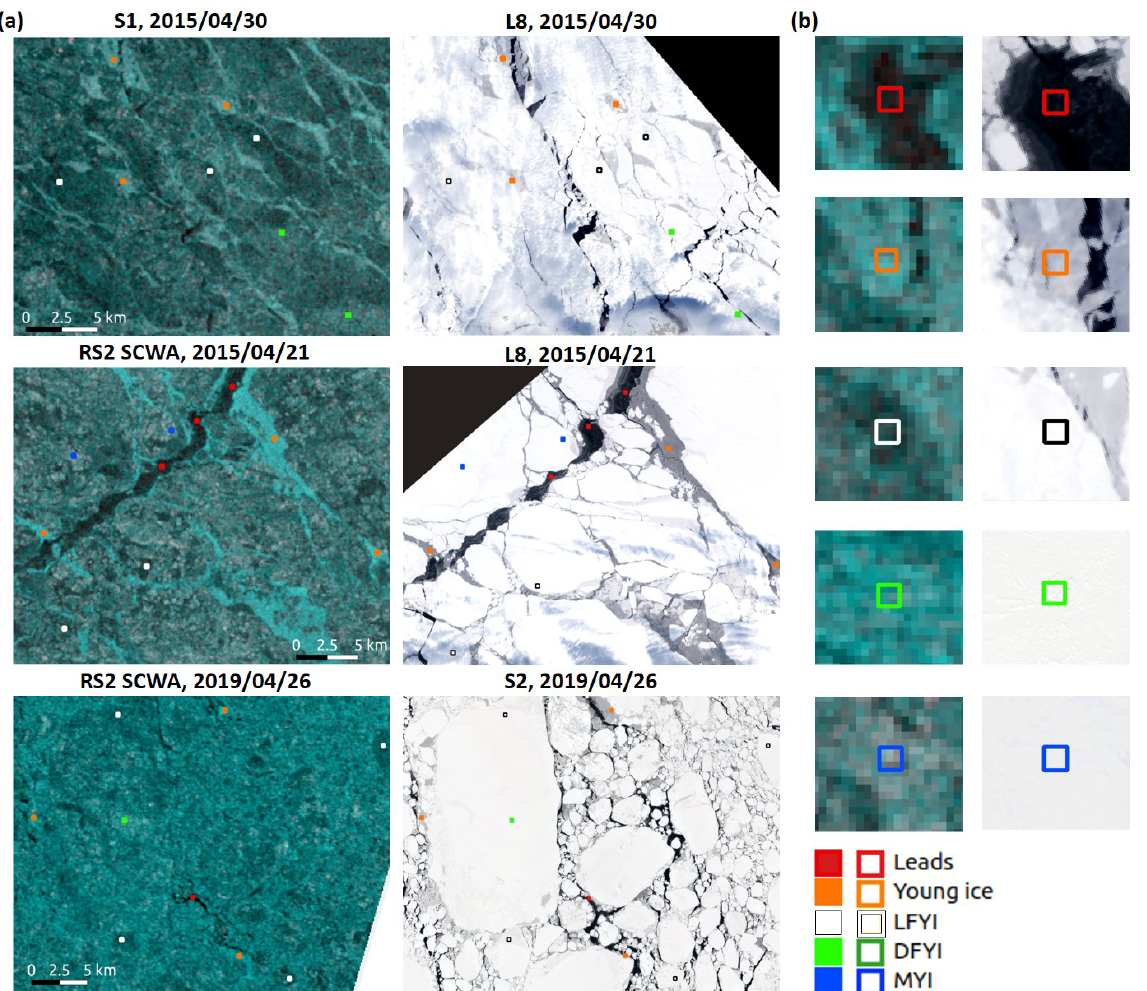
Figure 3. (a) Examples of reference polygons in different ice types in overlapping parts of SAR (false-color RGB composites: R:HV, G:HH, B:HH) and optical scenes and (b) examples of zoomed-in subsets for each